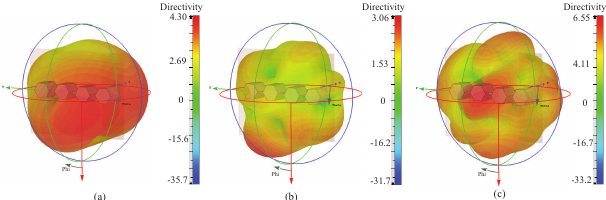
FIGURE 11: 3D directivity pattern of the proposed array at: (a) 1.52 GHz (b) 3.12 GHz and (c) 4.25 and TE x δ 02 δ 03